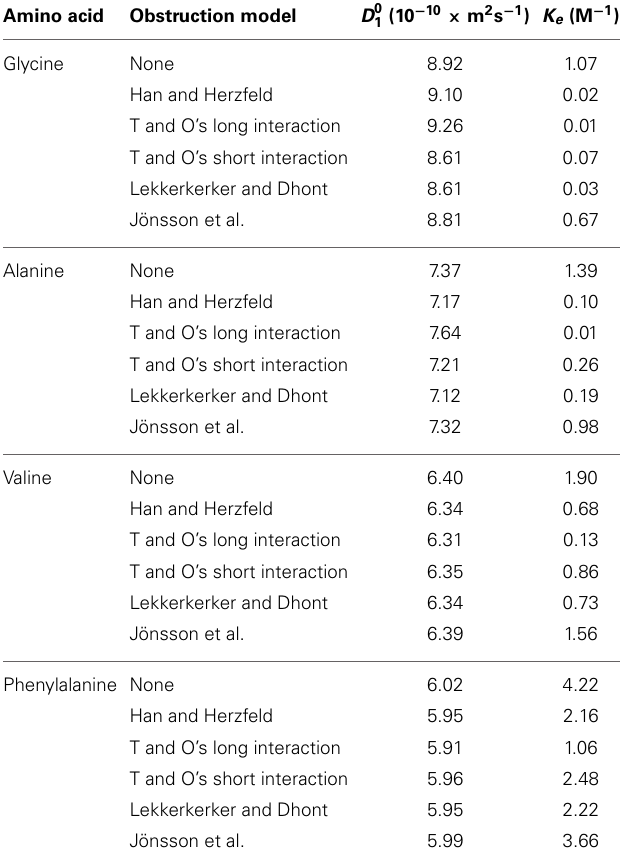
Table 1 | Summary of the fitting results from regressing Equation (12) including the isodesmic association model and various obstruction models [48, 65, 70, 71, 73] on to the experimental glycine, alanine, and valine and phenylalanine diffusion